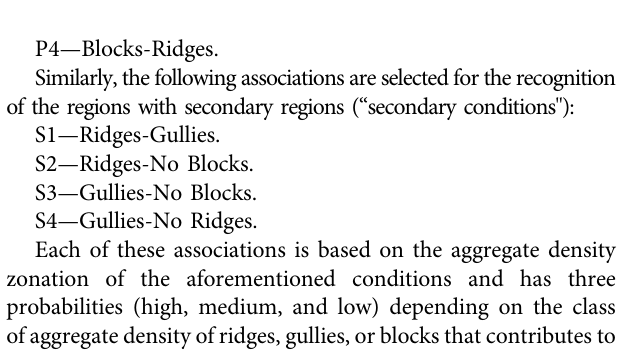
Frontiers in Earth Science |